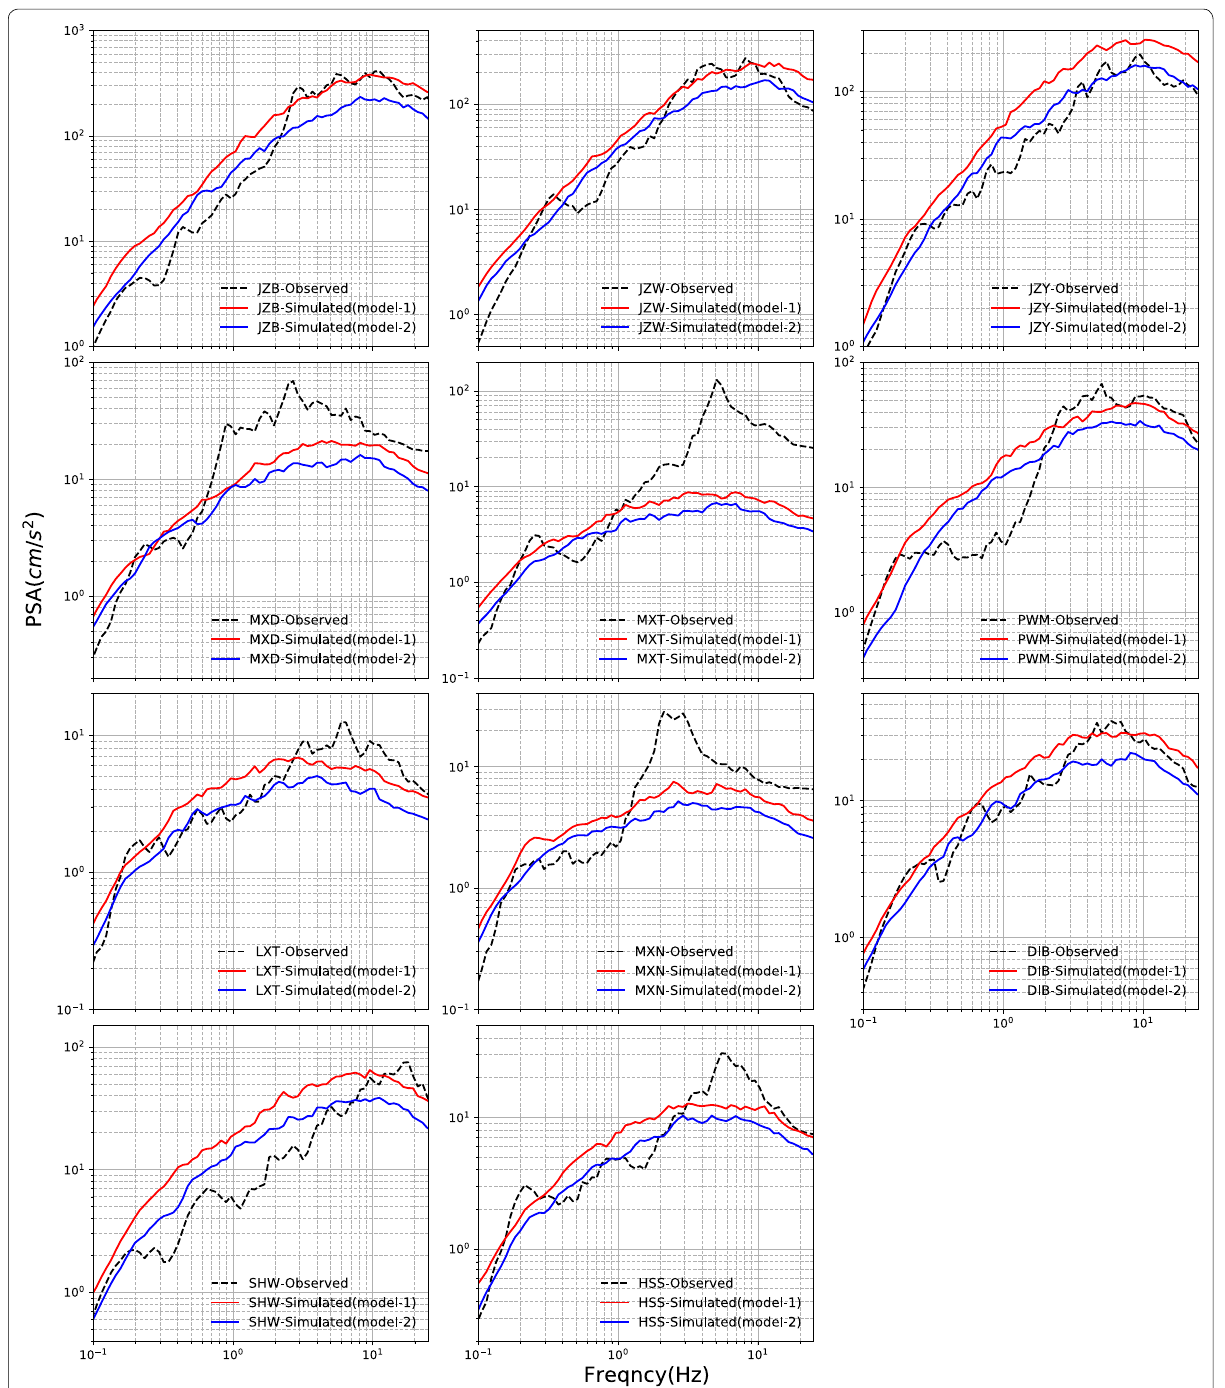
Fig. 7 Comparison of PSAs for the two models at selected stations. The observed (dashed lines) and simulated (solid lines) PSAs are shown. The red and blue lines denote simulated results from model 1 and model 2,